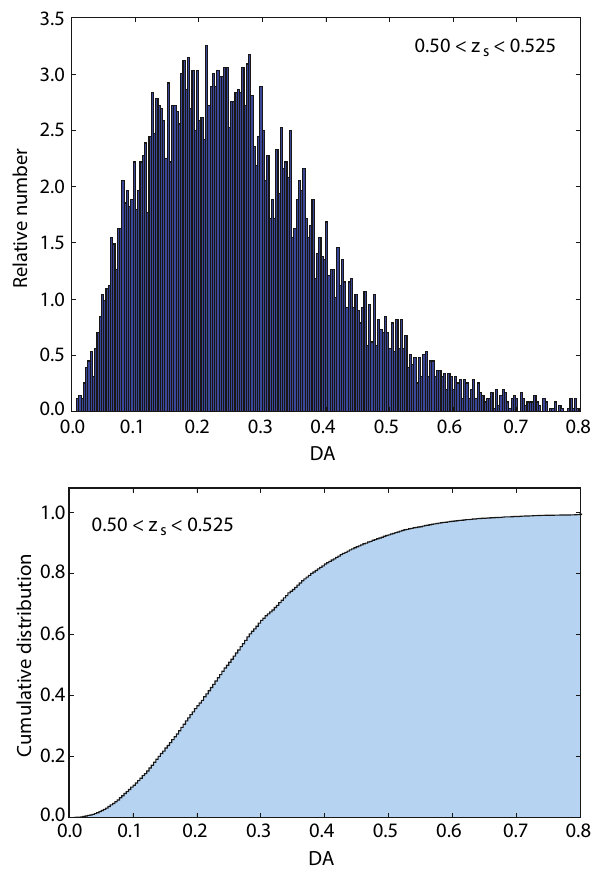
Fig. 1 Top panel: the distribution of frequency versus area differential DA for a mock sample with source shell 0 . 5 < z s < 0 . 525; and bottom panel: its corresponding cumulative probability